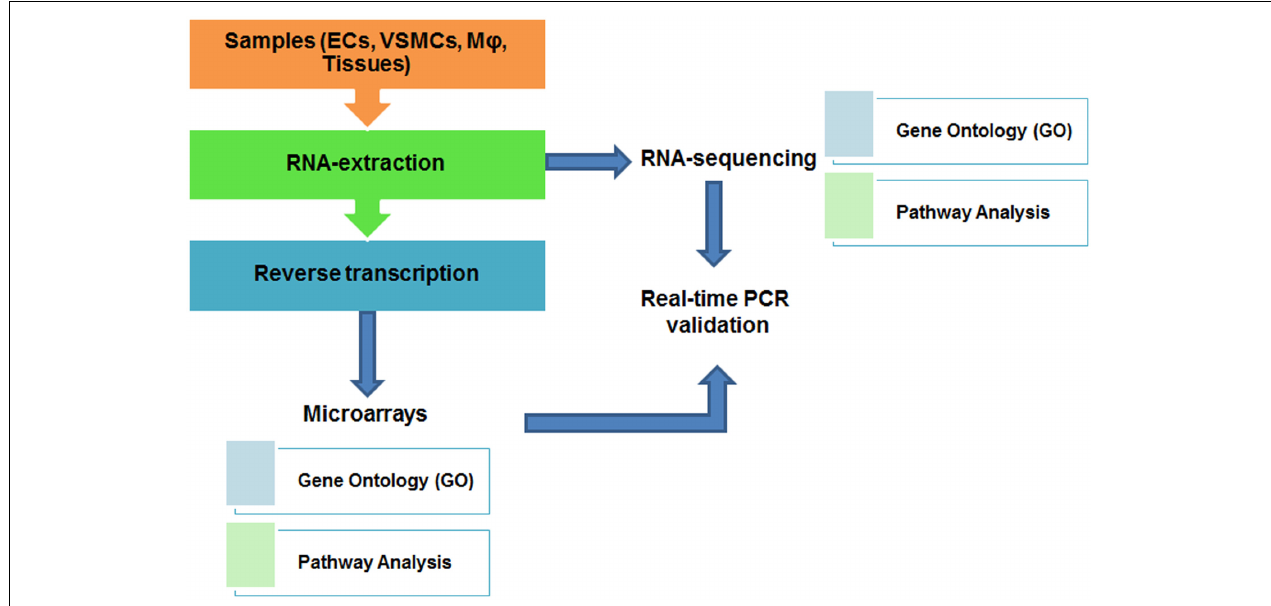
FIGURE 1 | Workflow and downstream analysis of transcriptome